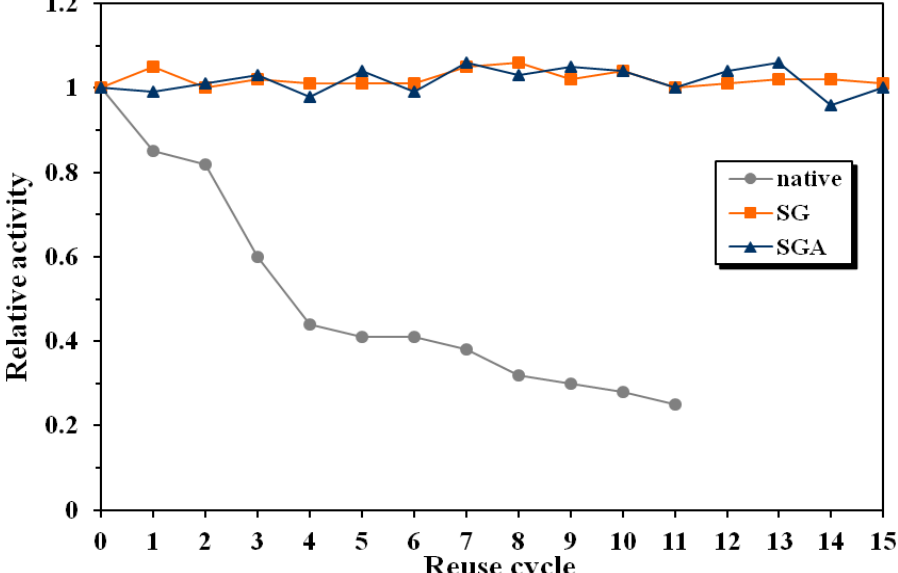
Figure 4. Influence of enzyme reuse on the relative activity of native and immobilized lipase from Candida antarctica B, in the enantioselective acylation of 2-octanol at 60 °C in n -hexane (native lipase, SG—sol-gel entrapped lipase, SGA—lipase immobilized by sol-gel entrapment and